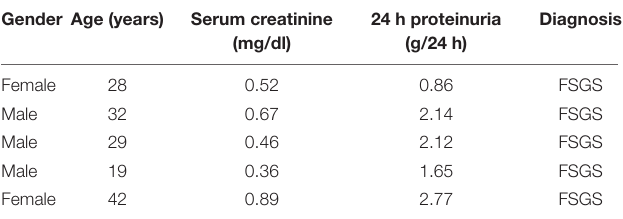
TABLE 1 | Clinical characteristics at the time of renal